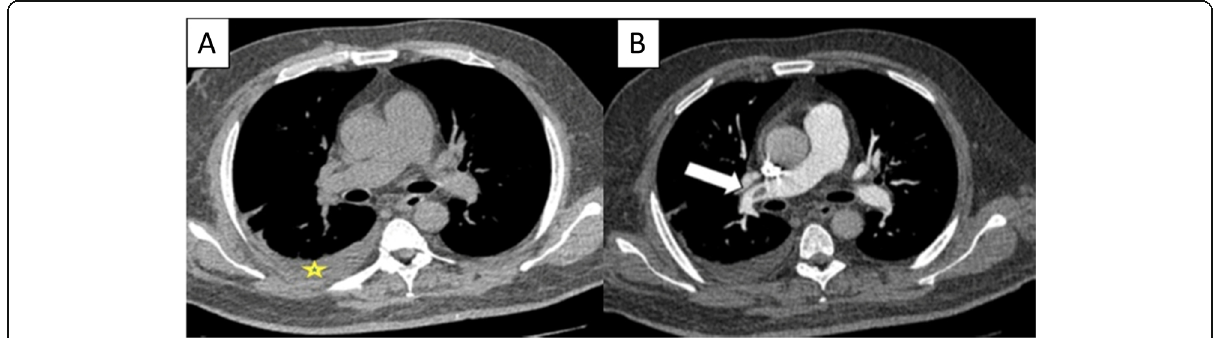
Fig. 3 a Axial non contrast CT image. b Axial CTPA image shows a case of false-negative finding of pulmonary embolism in non-contrast CT chest associated with right pleural effusion (asterisk in a ), with positive finding in CTPA as hypo dense filling defect seen partially occluding right main pulmonary artery (arrows in b